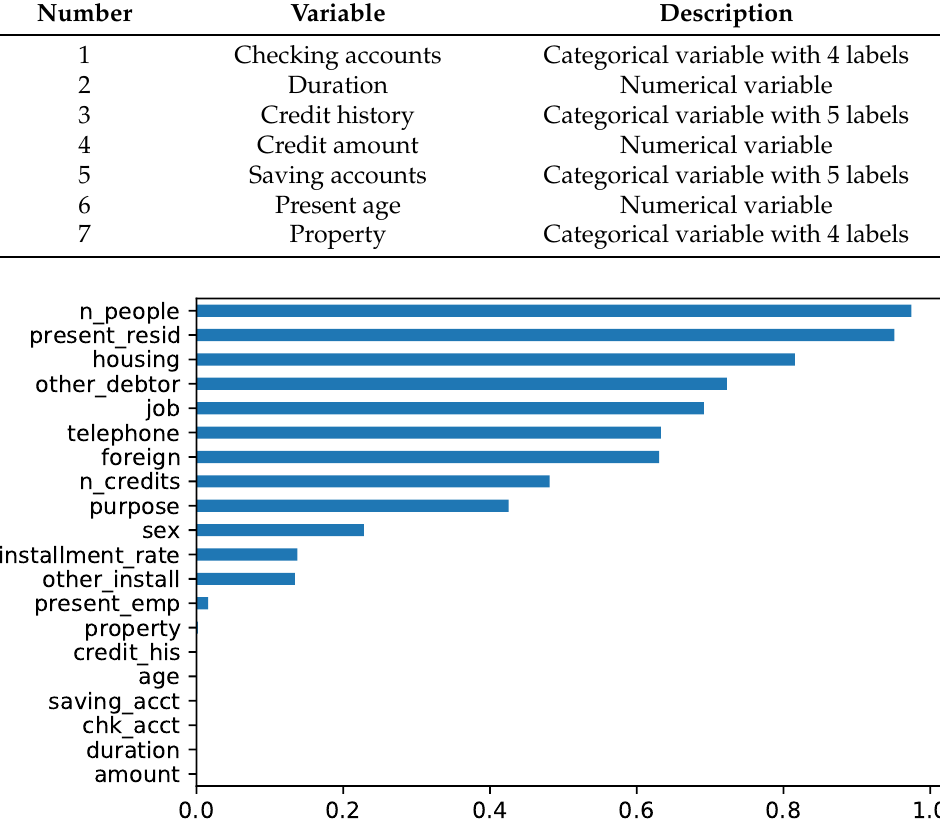
Figure 1. p -values of the chi-squared feature selection